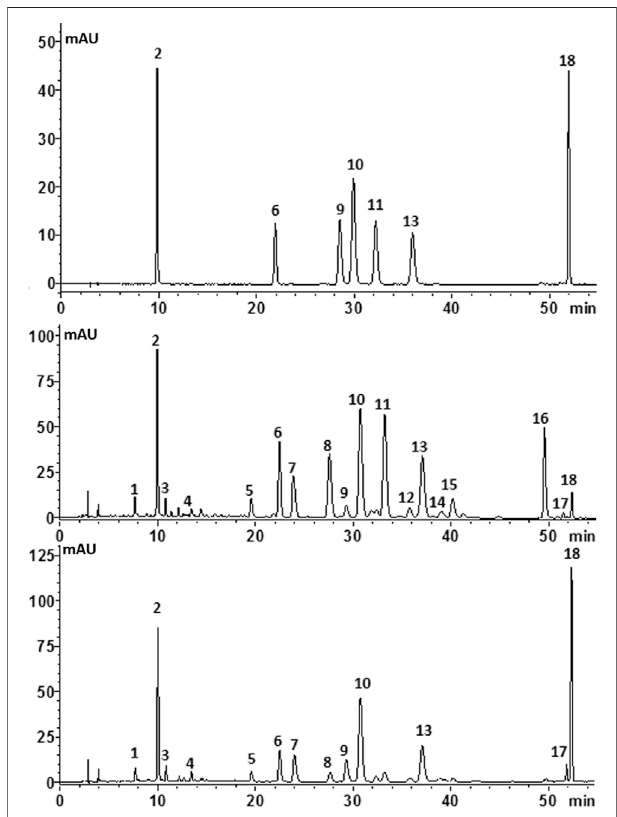
FIGURE 4 | Typical chromatograms of (A) mixed standard solution, (B) C.morifolium fl owerand (C) C.indicum fl owerwiththecompoundsnumbered as follows: (1) neochlorogenicacid; (2) chlorogenic acid; (3)cryptochlorogenic acid; (4) caffeic acid; (5) luteolin-7-O-rutinoside; (6) luteolin-7- O -glucoside; (7) luteolin-7 -O- glucuronide; (9) isochlorogenic acid B (10) isochlorogenicacidA(11)apigenin-7 -O- glucoside;(13)isochlorogenicacidC; (15) diosmetin-7- O -glucoside; (16) apigenin-7- O -6 ″ -malonylglucoside (18) linarin.